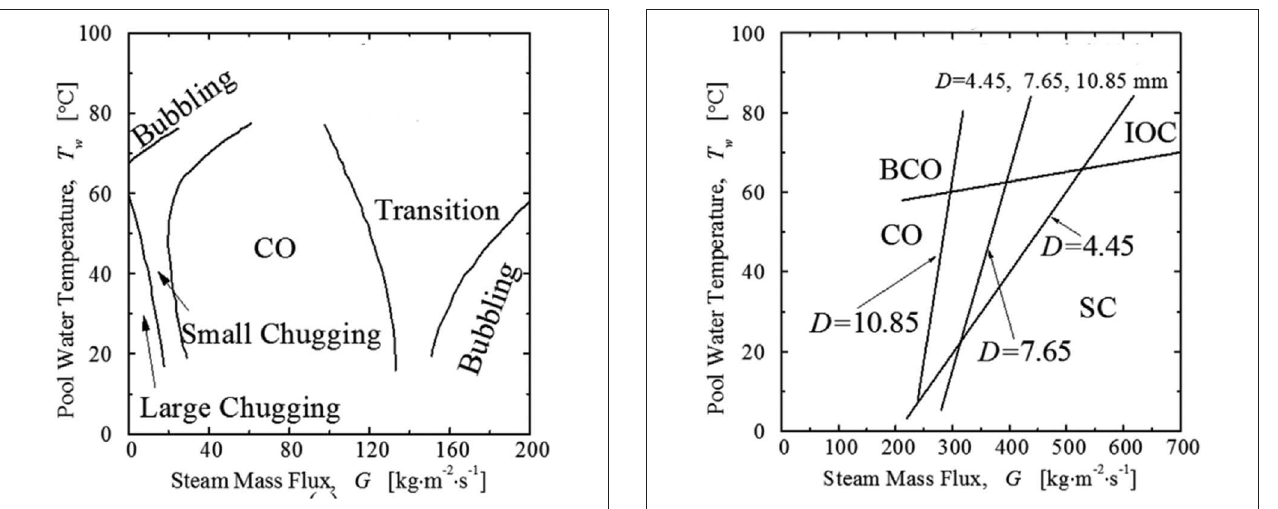
Large chugging/intermittent growth (La-C) : Pressure